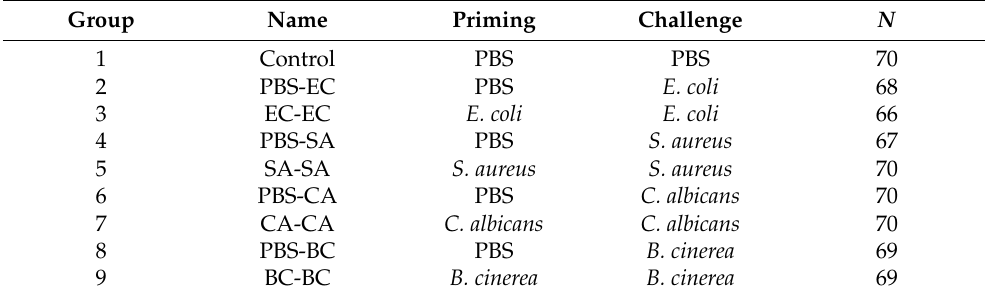
Table 1. Groups of experimental larvae according to the substance used for the priming and challenge. N corresponds with the number of larvae in each